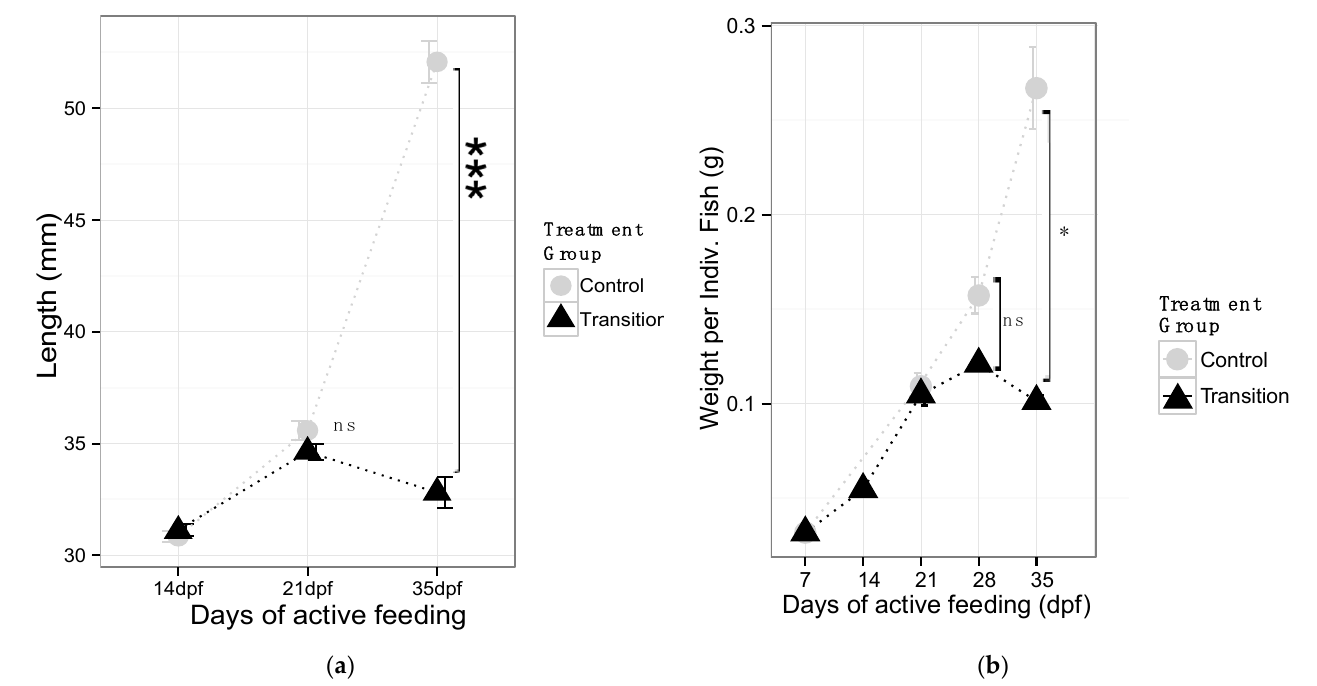
Figure 2. Larval lake sturgeon morphometric data. ( a ) Mean total length (mm) by treatment, at each sampling point; ( b ) average body weight (g) of larvae from each feeding treatment. Significant differences in treatment mean test based on a Welch- t test (ns indicates non-significant; * p -value < 0.05; *** p -value < 0.001). Table 1. Split-plot ANOVA (mixed design ANOVA) table for larval lake sturgeon. ( a ) Total length; ( b ) mean larval body weight indicate sources of variability between-tank replicate associated with feeding treatment and within-tank replicate associated with sampling times. A significant interaction was also observed between treatment and stages.